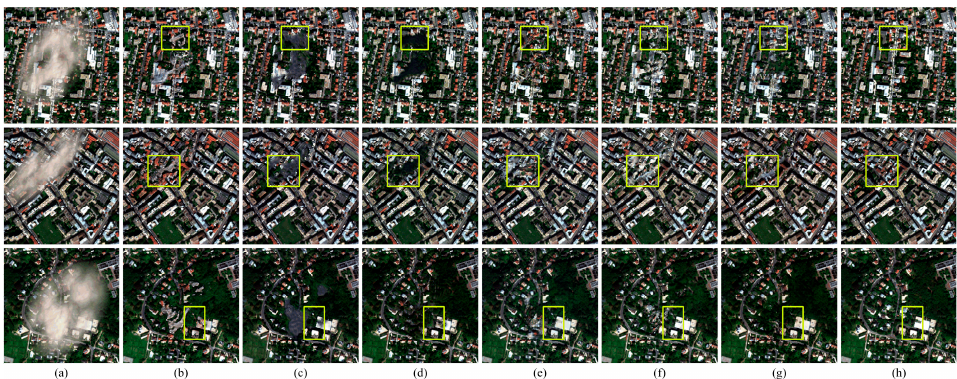
Figure 15. Results of each method for Paris dataset. ( a ) Cloudy images; ( b ) Cloud-GAN; ( c ) cGAN; ( d ) SpAGAN; ( e )McGAN; ( f ) AMGAN-CR; ( g ) DC-GAN-CL; ( h ) cloud-free images.